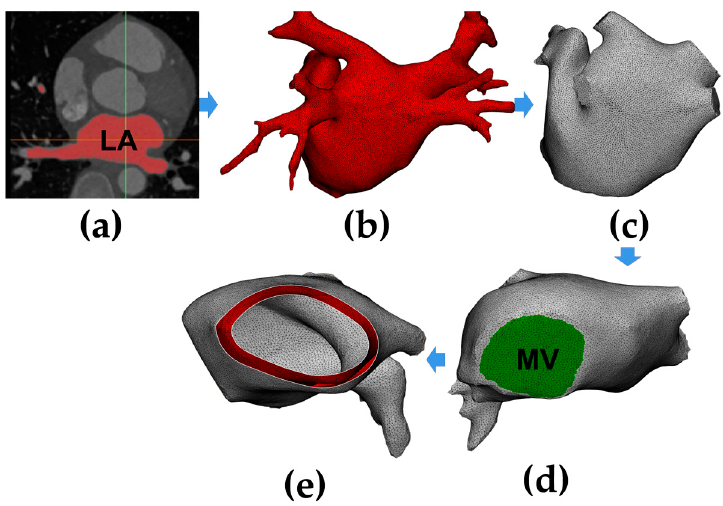
Figure 1. A flow chart of constructing an anatomy-based left atrium (LA) model. ( a ) Segment LA region from coronary computed tomography angiography (CTA) images; ( b ) generate the triangular mesh of the LA model; ( c ) trim the four pulmonary veins (PVs); ( d ) create the mitral valve (MV); ( e ) generate the LA model with the atrial wall.